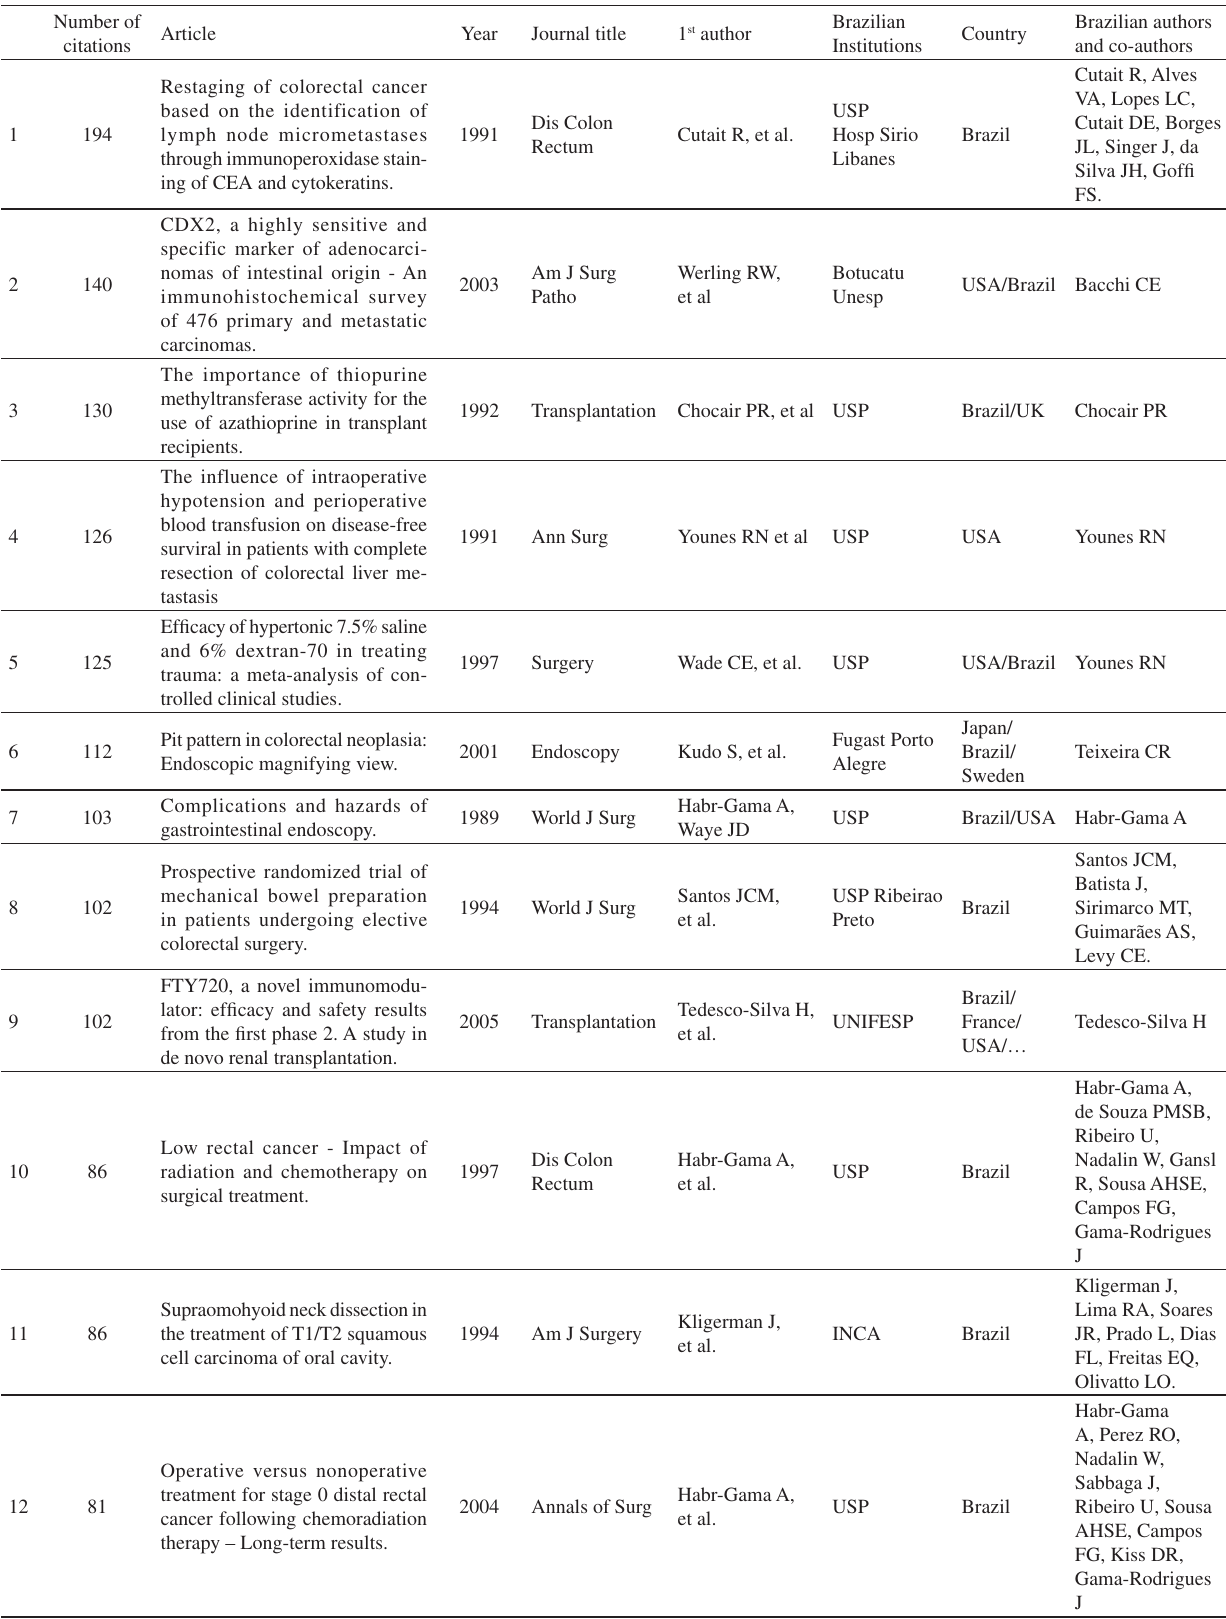
Table 5 - List of the Brazilian thirty most cited articles in general surgery, during the period of 1970-2009 years. Number of citations